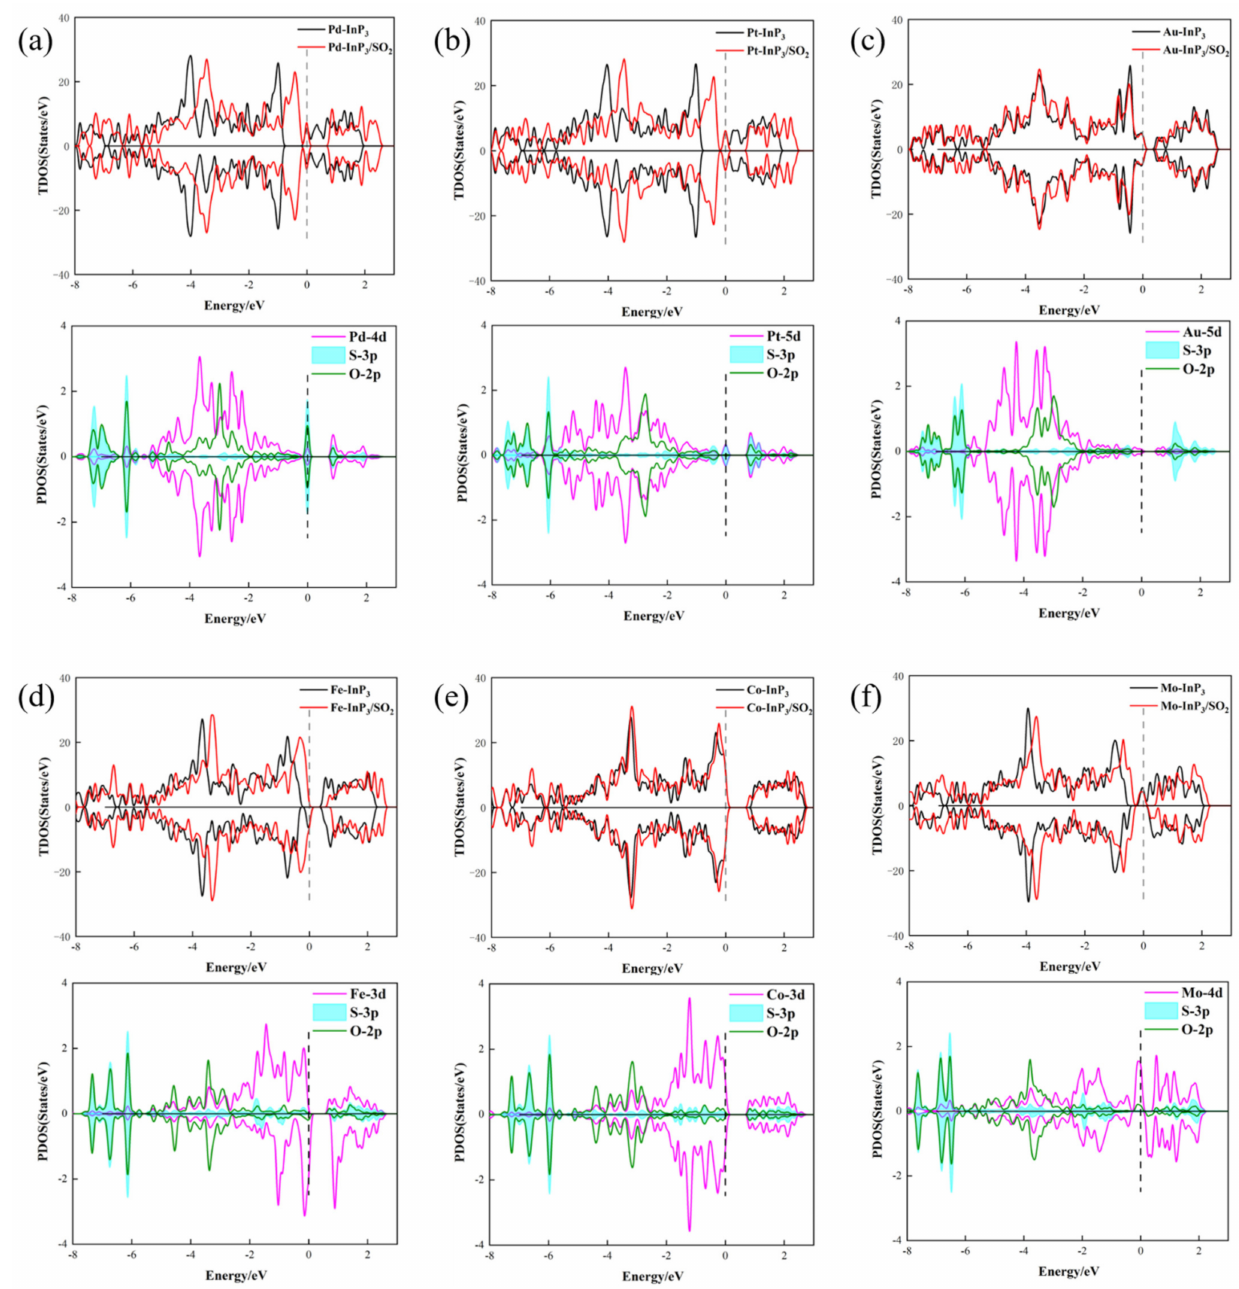
Figure 5. DOS of ( a ) Pd-InP 3 /SO 2 , ( b ) Pt-InP 3 /SO 2 , ( c ) Au-InP 3 /SO 2 , ( d ) Fe-InP 3 /SO 2 , ( e ) Co- InP 3 /SO 2 and ( f ) Mo-InP 3 /SO 2